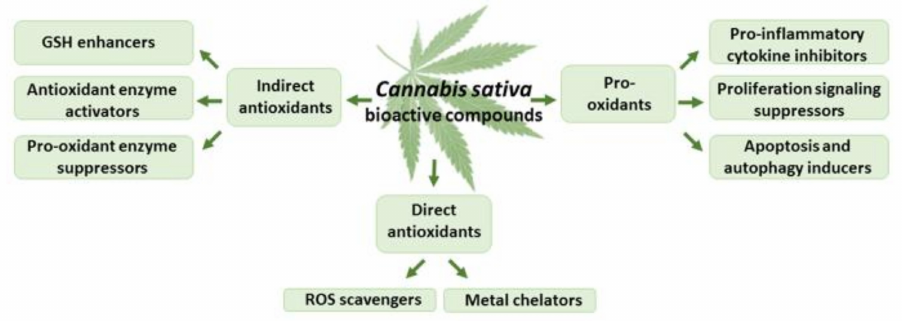
Figure 4. The effects of THC and CBD on oxidative